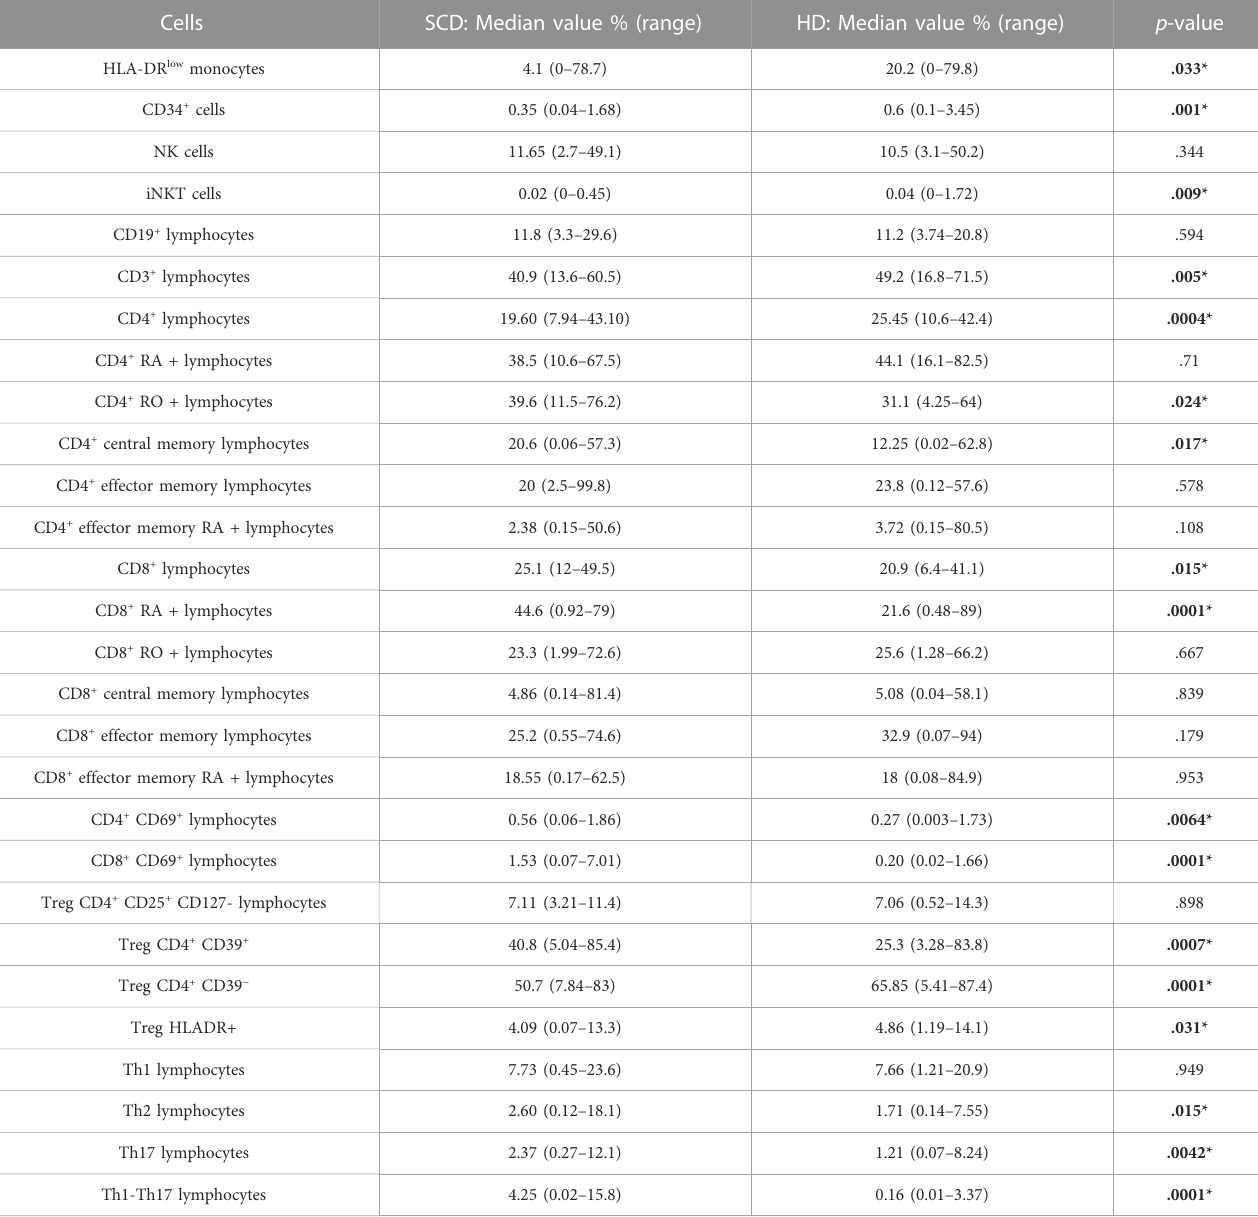
TABLE 4 Main differences in the immunological pro fi le (in percentage) between Sickle Cell Disease population and Healthy Donors. *Data with statistical signi fi